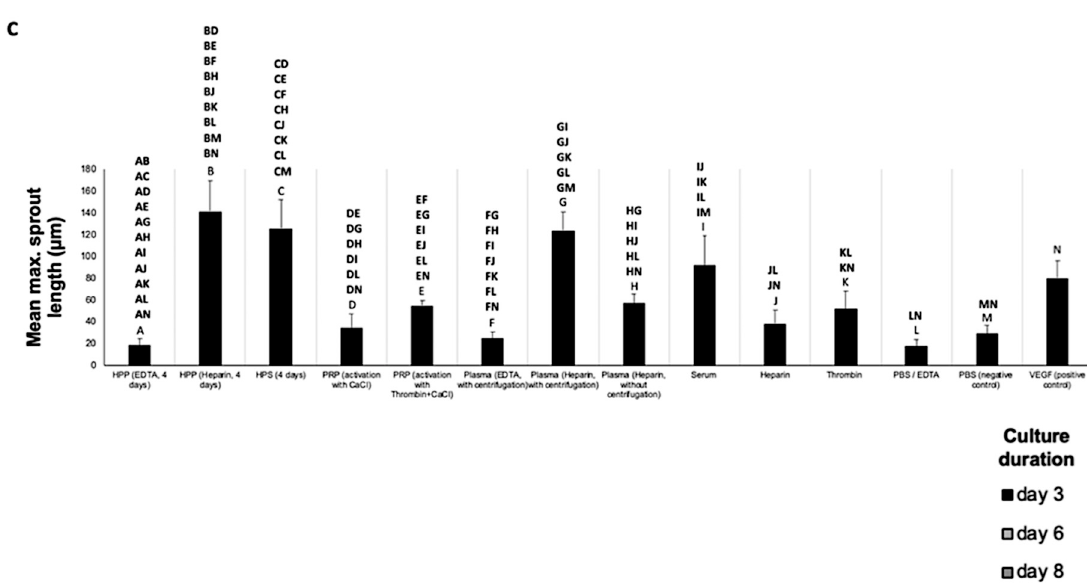
Figure 5. Effect of blood-derived secretomes on microvessel sprouting in the aortic ring assay in vitro. ( A ) Panel showing representative images of aortic rings, embedded in Matrigel and cultured in the presence of the shown blood-derived secretomes for 3, 6 and 8 days. (Bars = 100 µ m). Microvessels sprouting from aortic rings are indicated by black arrows. Enlarged image sections are indicated by red insets. ( B ) Plot showing the mean number of sprouts per ring over a culture duration of 3, 6 and 8 days ( n = 3). ( C ) Plot showing the mean maximum sprout length after a culture period of 8 days ( n = 3). Capital letter pairs over plots indicate statistical comparison of corresponding data points. For all pair comparisons, p < 0.05, unless otherwise indicated. Error bars represent s.d.